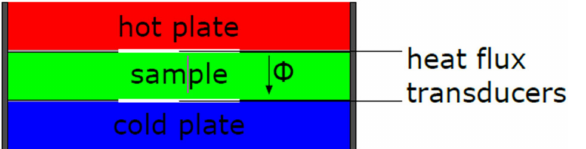
Figure 4. Sketch of a heat flow meter (HFM) with a symmetrical arrangement and one slab.